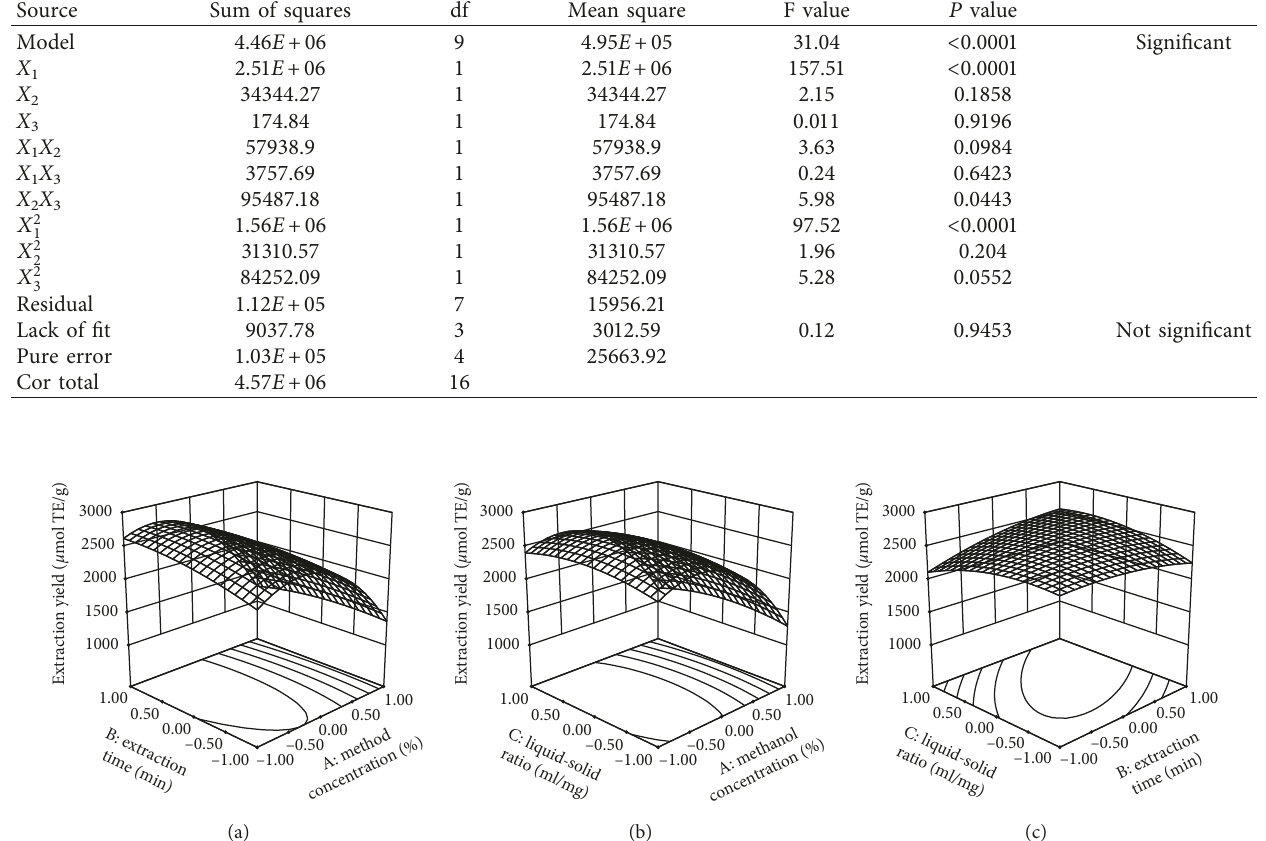
Table 4: Variance analysis of regression equations.